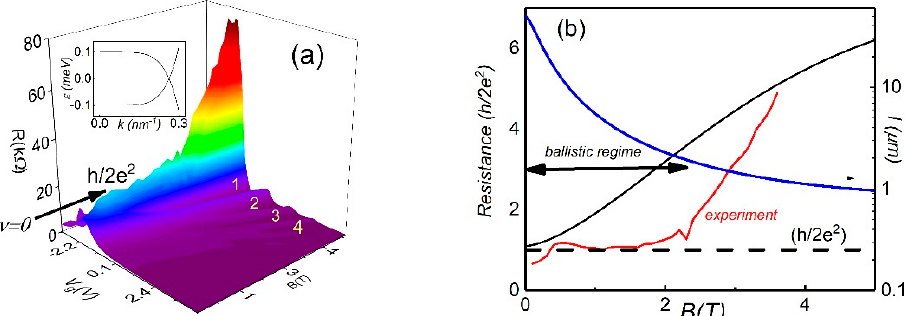
Figure 2. (Color online) ( a ) The color map of R xx ( N s , B ) versus N s and B at T = 4.2 K for mesoscopic device. The arrow indicates the plateau of resistance at ν = 0. The insert shows the counterpropagating spin-polarized edge states in the presence of a strong perpendicular magnetic field. ( b ) The red trace represents the longitudinal R xx resistance as a function of the magnetic field ( B ) at the CNP. The black line shows the theoretical resistance calculated from the model [31]. The blue line represents the B dependence of the mean free path calculated from the model [31].